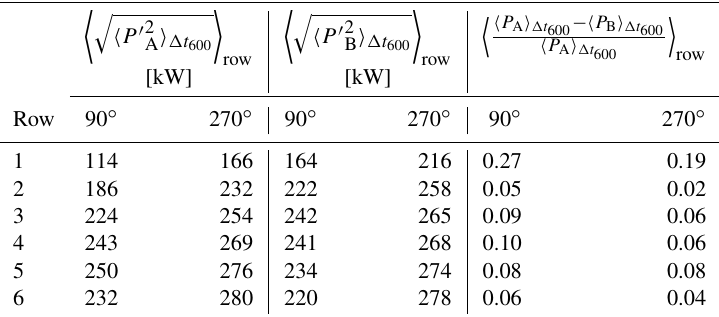
(cid:113) (cid:104) P (cid:48) 2 (cid:105) (cid:49)t is the standard deviation of the power output fluctuations of A 600 and (cid:104) P B (cid:105) (cid:49)t are the 600 600